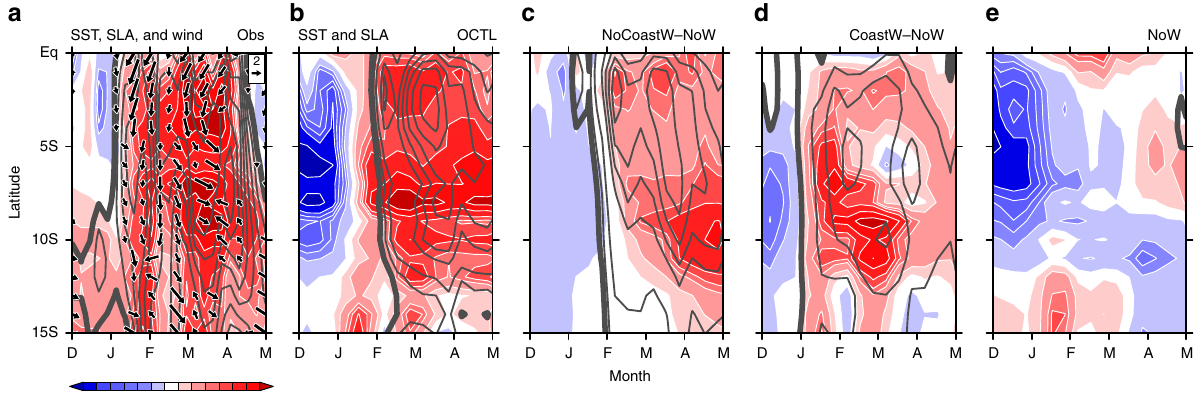
Fig. 5 Latitude – time evolution of the 2017 extreme coastal El Niño. Hovmöller diagrams for: a SSTA (color shading; °C), SLA (contours with an interval of 1 cm; zero thickened and negative omitted) and wind anomalies (vectors; m s − 1 ) from observations. b – e same as a but from MITgcm: OCTL,